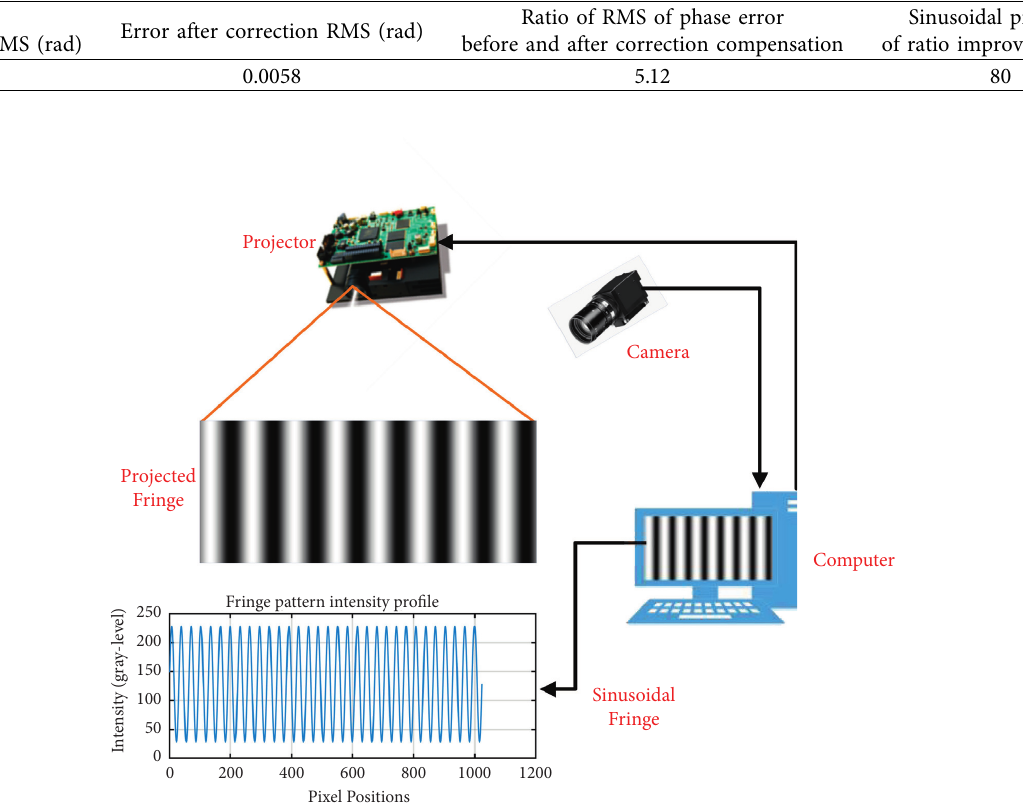
Figure 7: Schematic diagram of the digital fringe projection measurement